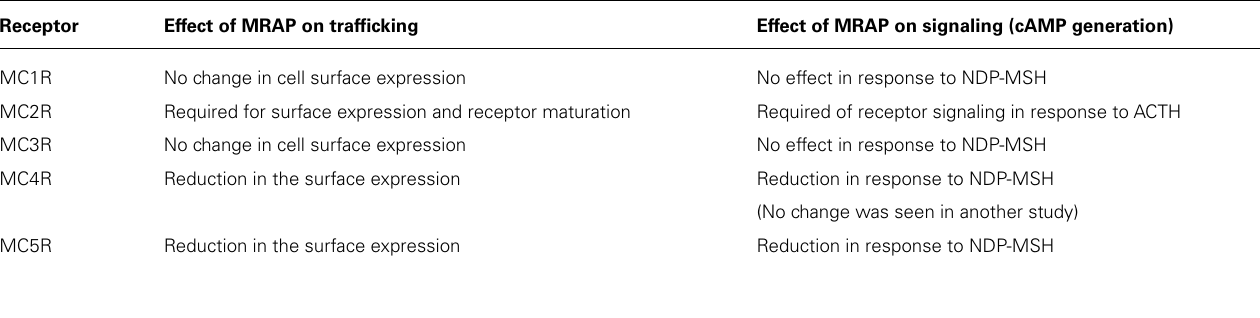
Table 2 | In vitro effects of MRAP on melanocortin receptors, based on data derived from Metherell etal. (2005) Sebag and Hinkle (2007, 2009a, 2010), Chan etal. (2009b) and Cooray etal. (2011). Receptor Effect of MRAP on